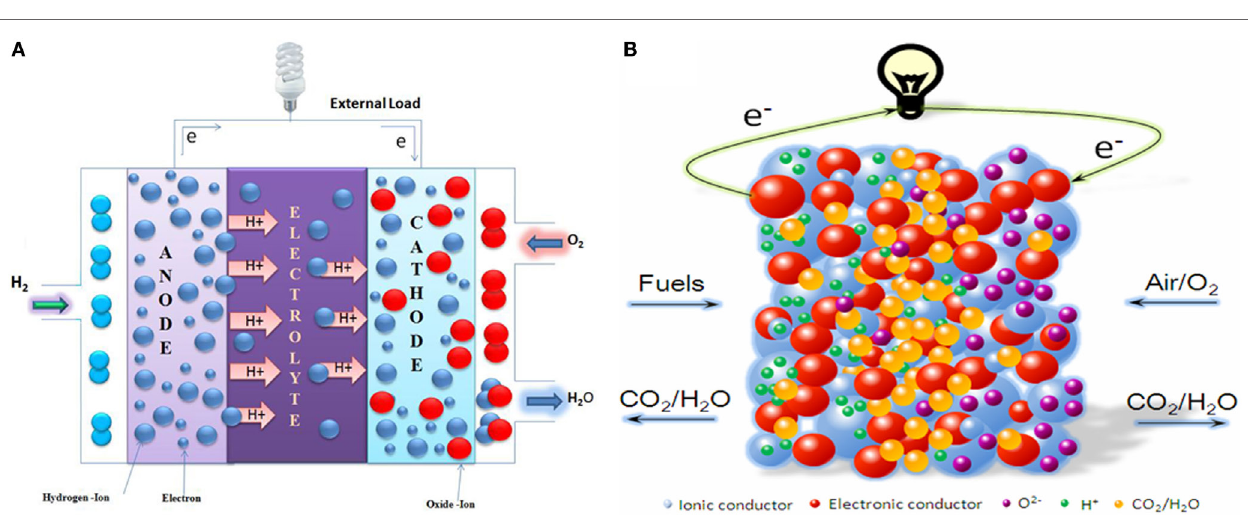
FiGURe 2 | Comparison of working principle between (A) SOFC and (B) eFFC, or called single component .